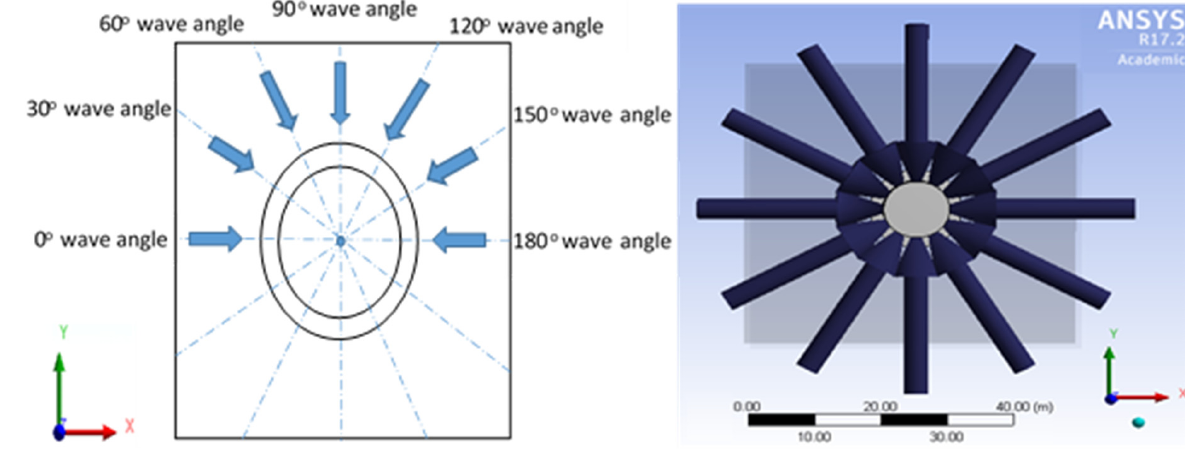
Figure 14. Definition of wave angles on the buoy at 30 o intervals showing wave heading. Table 9. Wind and current